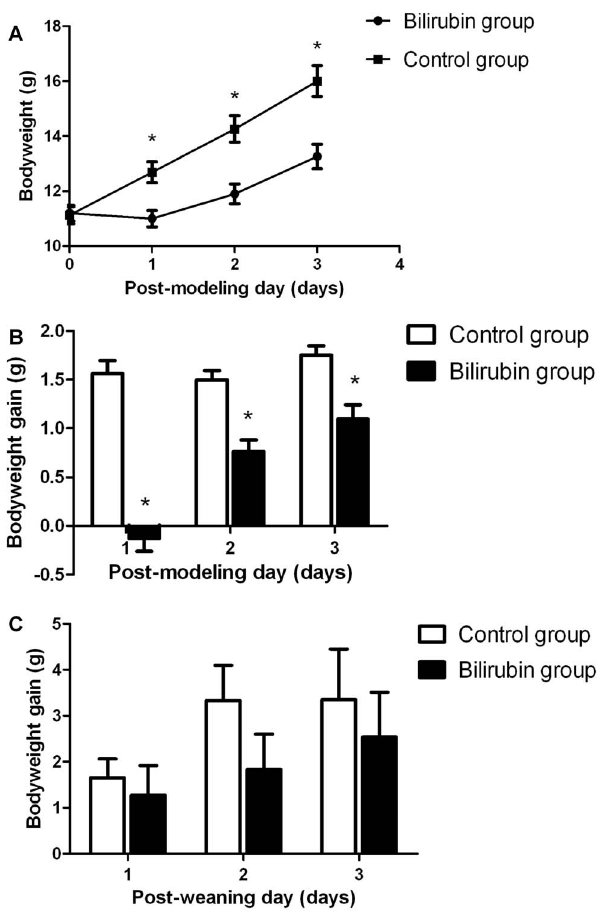
Figure 2. Bodyweight changes within 3 days after bilirubin injection or weaning. (A) Bodyweights of the bilirubin-treated rats and control rats on PMDs-1/2/3. (B) Bodyweight gains of the bilirubin- treated rats and control rats on PMDs-1/2/3. (C) Bodyweight gains of the bilirubin-treated rats and control rats on PWDs-1/2/3. (n=12 in each group). *: P , 0.01 vs control group. (PMD: post-modeling day; PWD: post-weaning day).